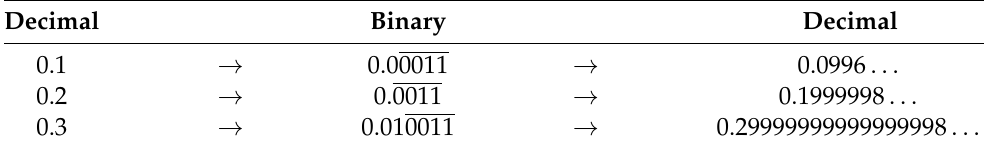
Table 2. Examples for decimal to binary conversion and vice